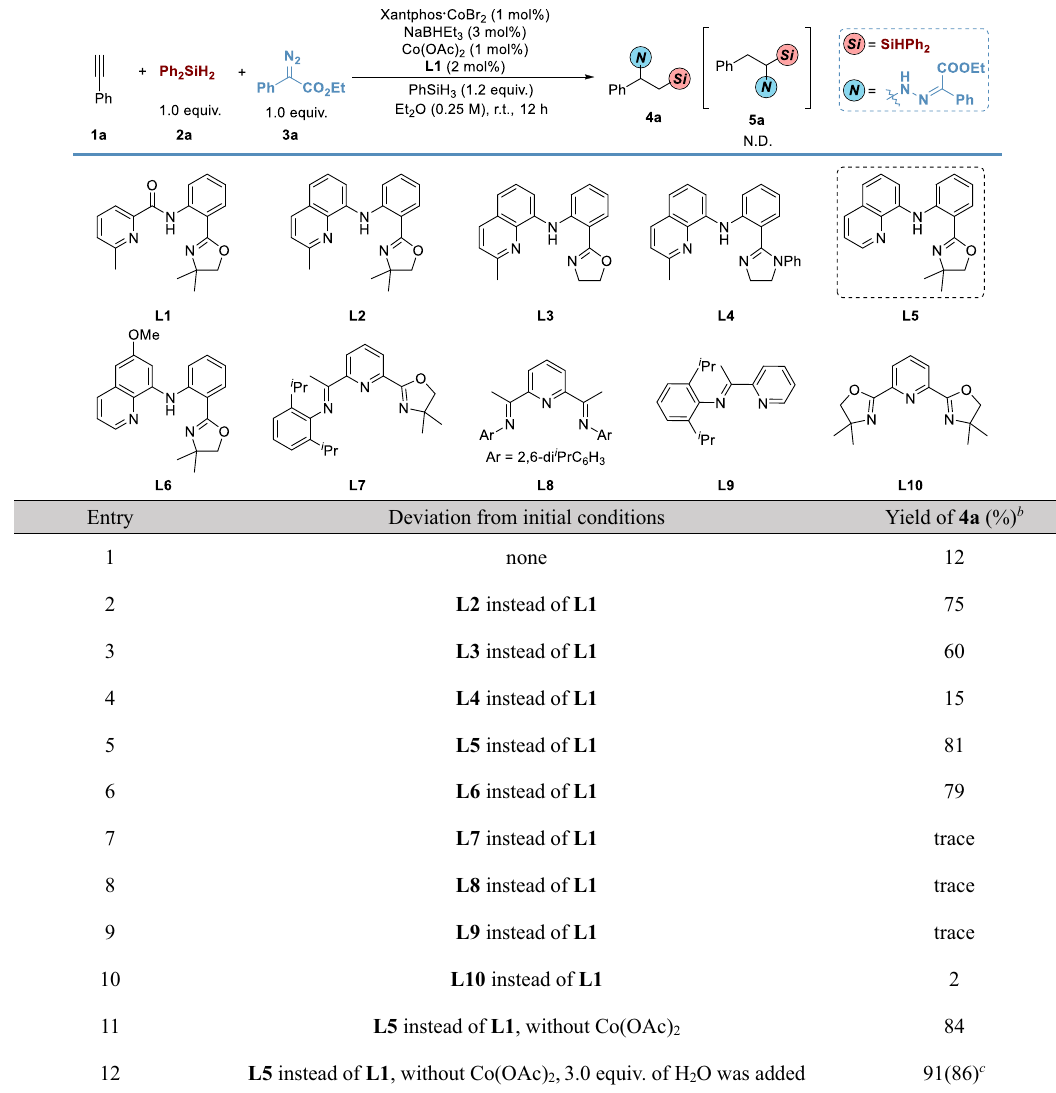
Fig. 3 Optimization of Sequential Hydrosilylation/Hydrohydrazidation of Terminal Alkynes via Ligand Relay Catalysis. a Reaction conditions: 1a (0.3 mmol), 2a (1.0 equiv.), 3a (1.0 equiv.), Xantphos (cid:129) CoBr 2 (1 mol%), NaBHEt 3 (3 mol%), Co(OAc) 2 (1 mol%), L1 (2 mol%) and PhSiH 3 (1.2 equiv.) in Et 2 O (1.2 mL) at room temperature under nitrogen for 12 h. b Yield was determined by 1 H NMR using TMSPh as an internal standard. c Isolated yield was in parentheses. TMSPh =